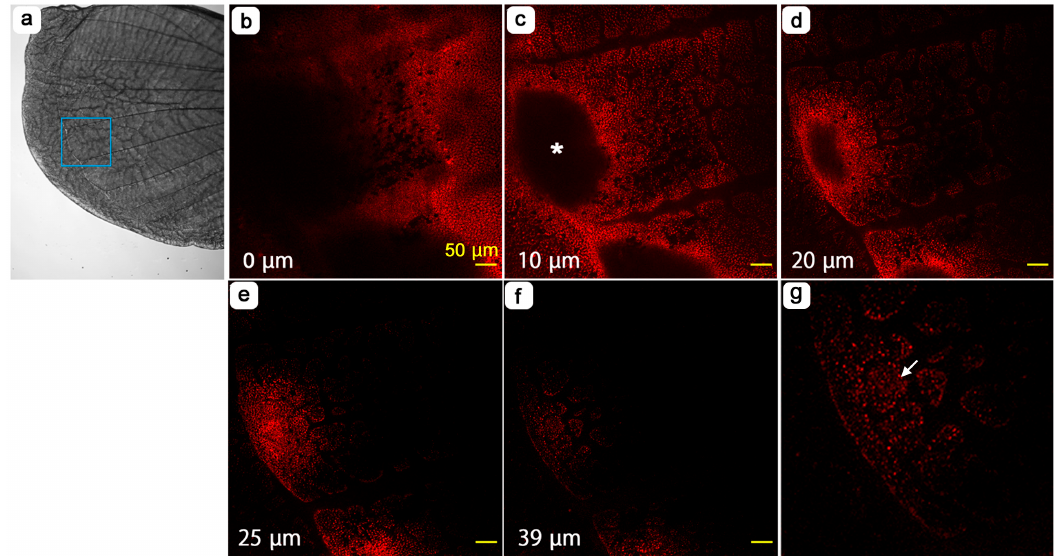
Figure 13. Dent at the wing margin identified by mitochondrial staining. ( a ) Bright-field image of the